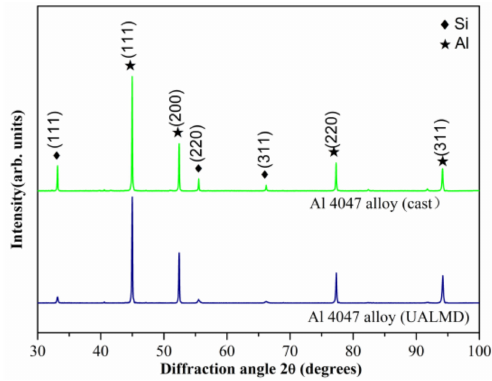
Figure 5. XRD patterns of the Al 4047 alloys produced using casting and UALMD